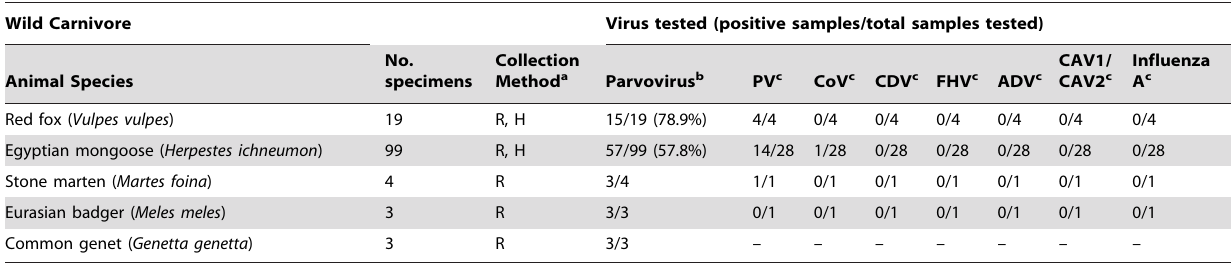
Table 1. Results of the virological survey in free-ranging wild carnivores from Portugal.